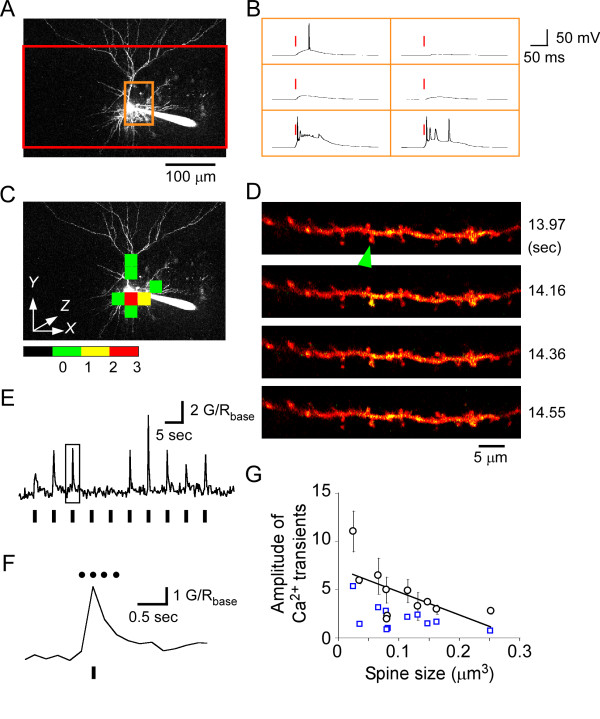
2pMAPG induction of action potentials in a layer 2/3 cell and detection of Ca2+ transients in a dendritic spine of a layer 5 cell. (A) A Z-stacked image of a representative layer 2/3 pyramidal cell filled with Alexa Fluor 594. The depth of the soma was 82 μm from the slice surface. The red region was divided into 16 × 8 pixels in a single plane and 2pMAPG was performed at each pixel at depths of 30, 80 and 130 μm from the top of the slice. (B) Each trace represents the membrane potential derived from 2pMAPG performed at each pixel in the orange-boxed region in (A) at a depth of 80 μm. Red bars indicate the time of 2pMAPG. (C) Green, yellow, and red pixels indicate AP-evoking pixels detected at any one of the three depths (30, 80 or 130 μm), at any two of these three depths, or at all of the three depths, respectively. (D) A single electrical stimulation near the dendrite induced a Ca2+ transient in one of the dendritic spines in the imaging region (arrow). Red (Alexa Fluor 594) fluorescence and green (Fluo-5F) fluorescence are overlaid. The overlapping signals appear yellow. The time interval between images was 194 ms. The time from the onset of sequential imaging is indicated to the right of each figure. (E) The G intensity/R intensity (G/R) trace in the spine is indicated with an arrow in (D) for 10 electrical stimuli at 0.2 Hz. (F) Expanded G/R trace is boxed in (E). Four dots indicate the acquisition times of the four imaging frames shown in (D). (G) The mean amplitudes of Ca2+ transients (black circle) and the mean 5 coefficients of variance of G/Rbase (blue rectangle) are plotted against spine size. The regression line for Ca2+ transients is shown. Bars, standard error of mean.